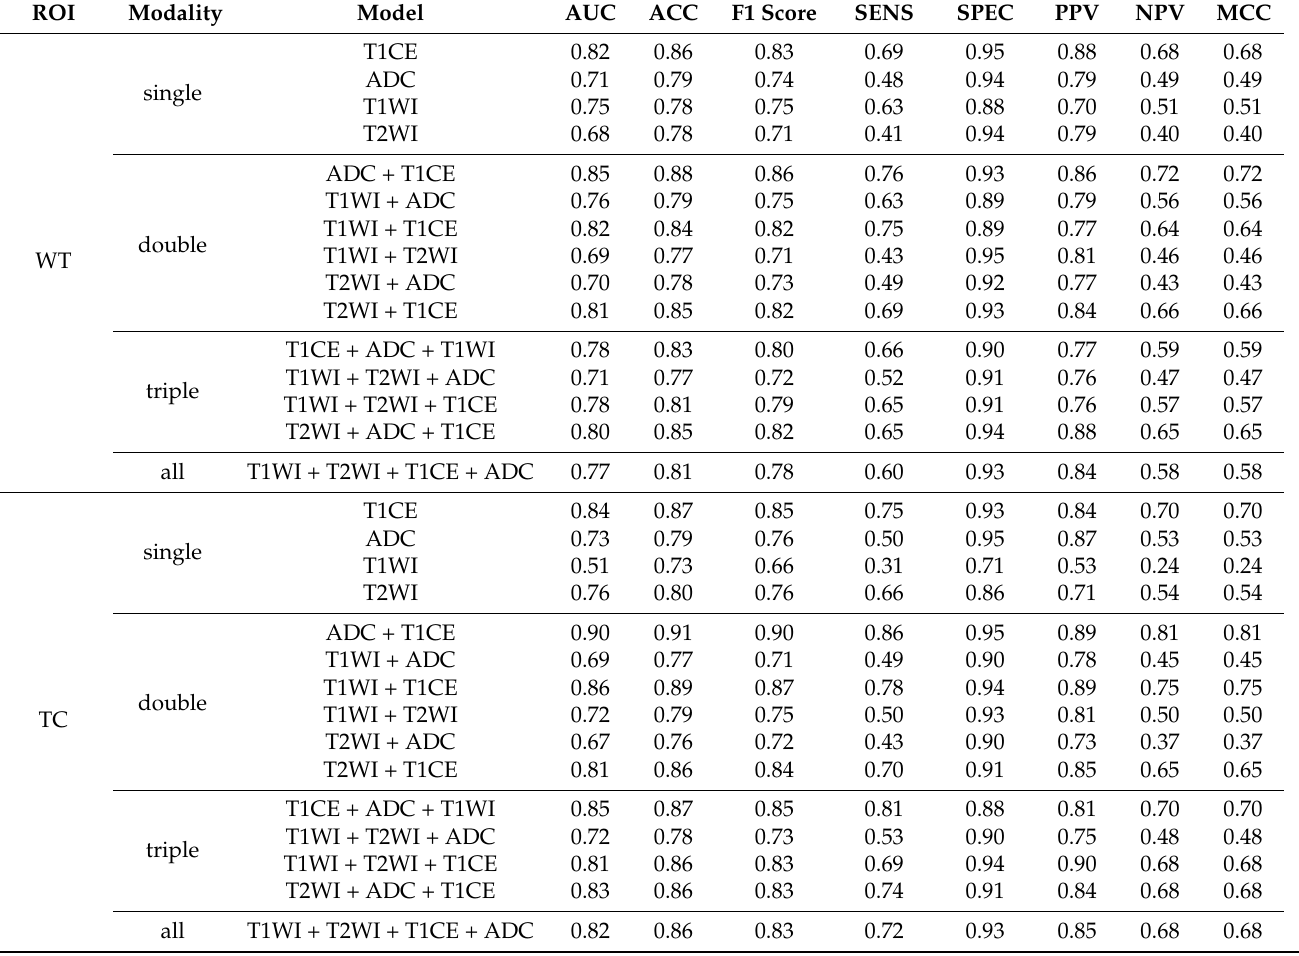
Table 2. Results of all